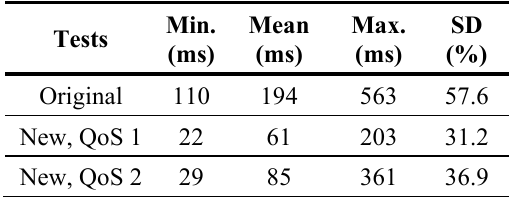
Table 1. Main statistics concerning the measured communication